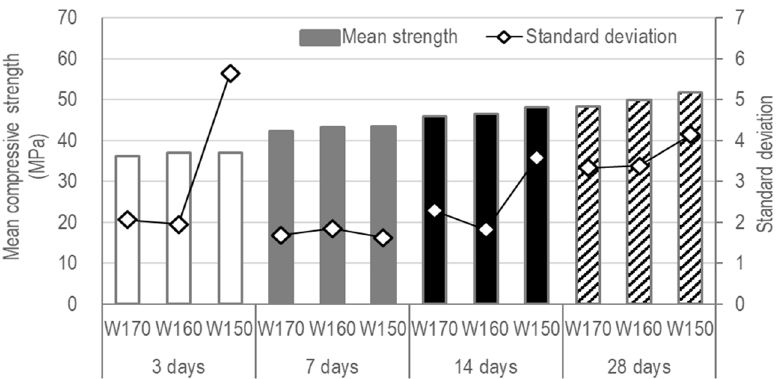
Figure 8. Mean compressive strengths and standard deviations of concrete mixtures with different water contents.